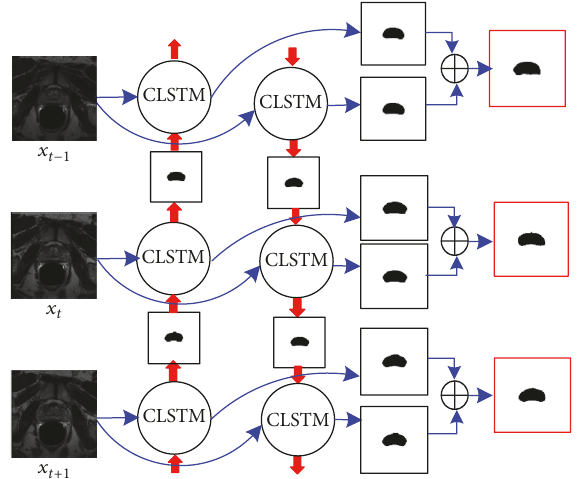
Figure 8: The architecture of BDC-LSTM. One BDC-LSTM layer contains two CLSTM layers working in two opposite directions. One from 𝑥 𝑥 𝑥 𝑥 𝑡+1 to 𝑡−1 and the other from 𝑡−1 to 𝑡+1 . The results of two CLSTM layers are connected together as the input of next layer.